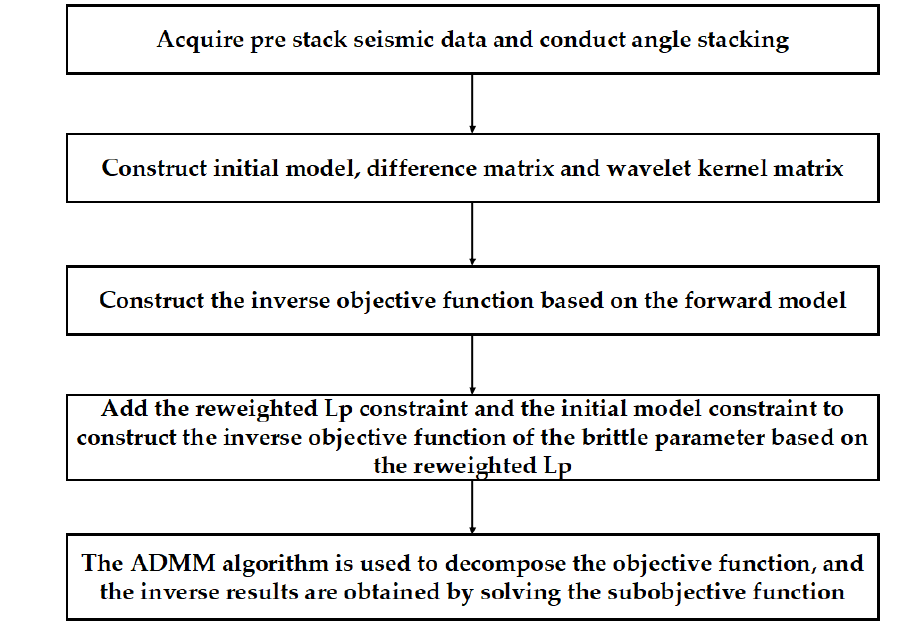
Figure 1. Inversion flow.